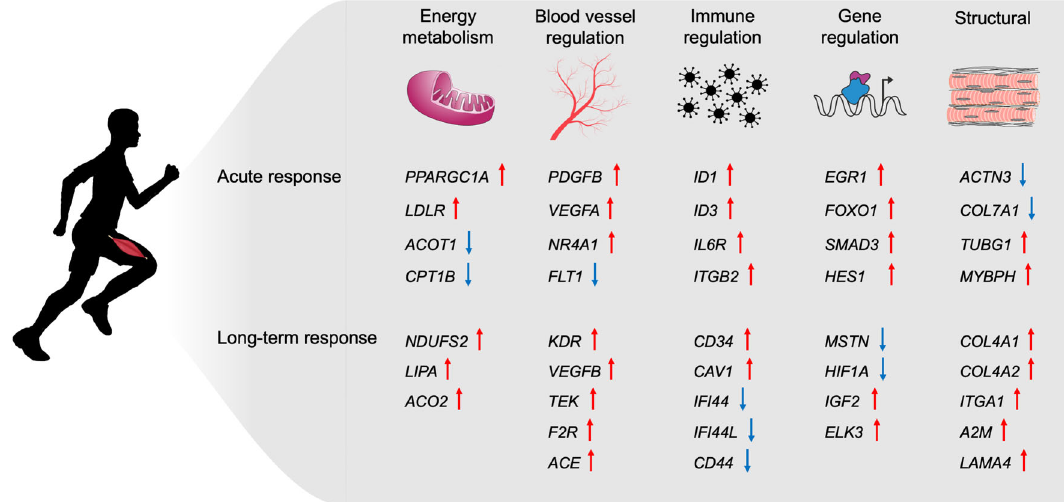
Fig. 7 Overview of selected gene expression changes. Summary of changes associated with key known adaptation mechanisms in skeletal muscle. Arrows indicate direction of change based on the base model from the meta-analysis. Source data are provided as a Source Data fi